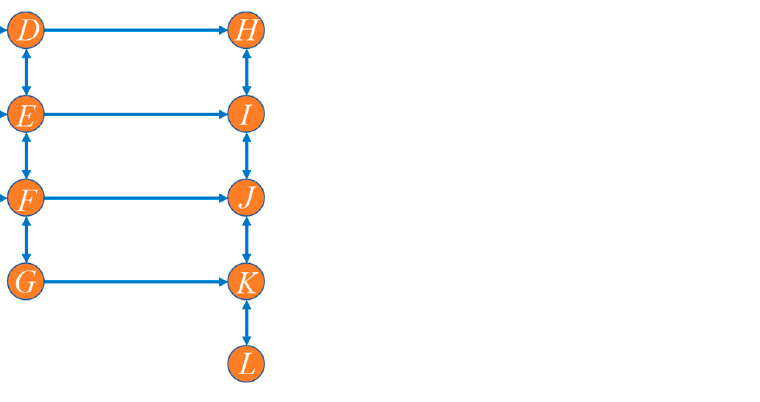
Figure 8. The directed graph abstracted from the lane group shown in Figure 7. The arrows indicate the travel directions. Two-way arrows represent mutual access; for example, the two-way arrow between D and E indicates that the vehicle can move from D to E and E to D.